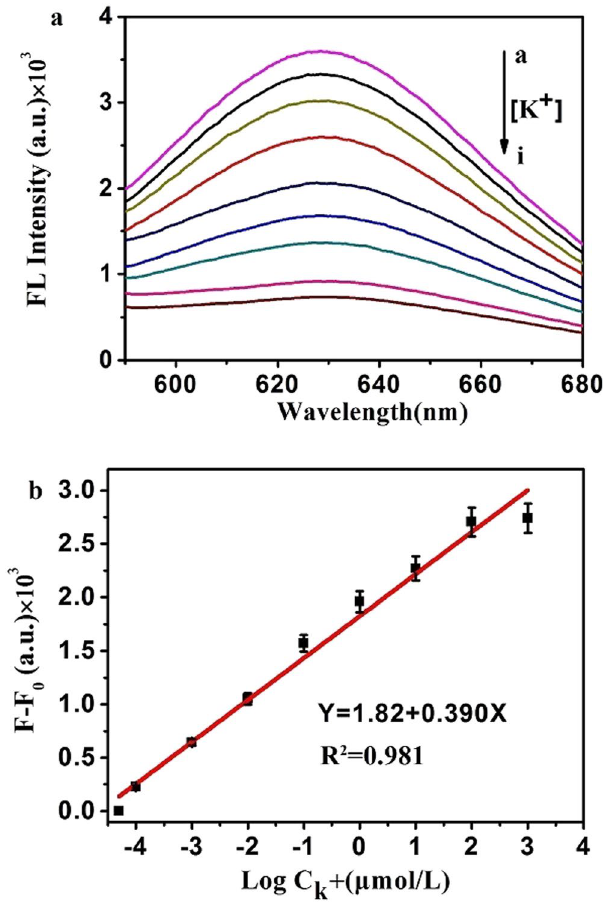
Figure 4. ( a ) Fluorescence spectra of DNA-AgNCs in the presence of different concentrations of K + ions (from a to i), ranging from 0.1 nM to 1 mM. ( b ) Linear calibration curve between fluorescence intensity changes and the logarithm of K + ions concentrations. F and F 0 refer to the fluorescence intensities of the DNA-AgNCs system in the absence and presence of K + ions, respectively.